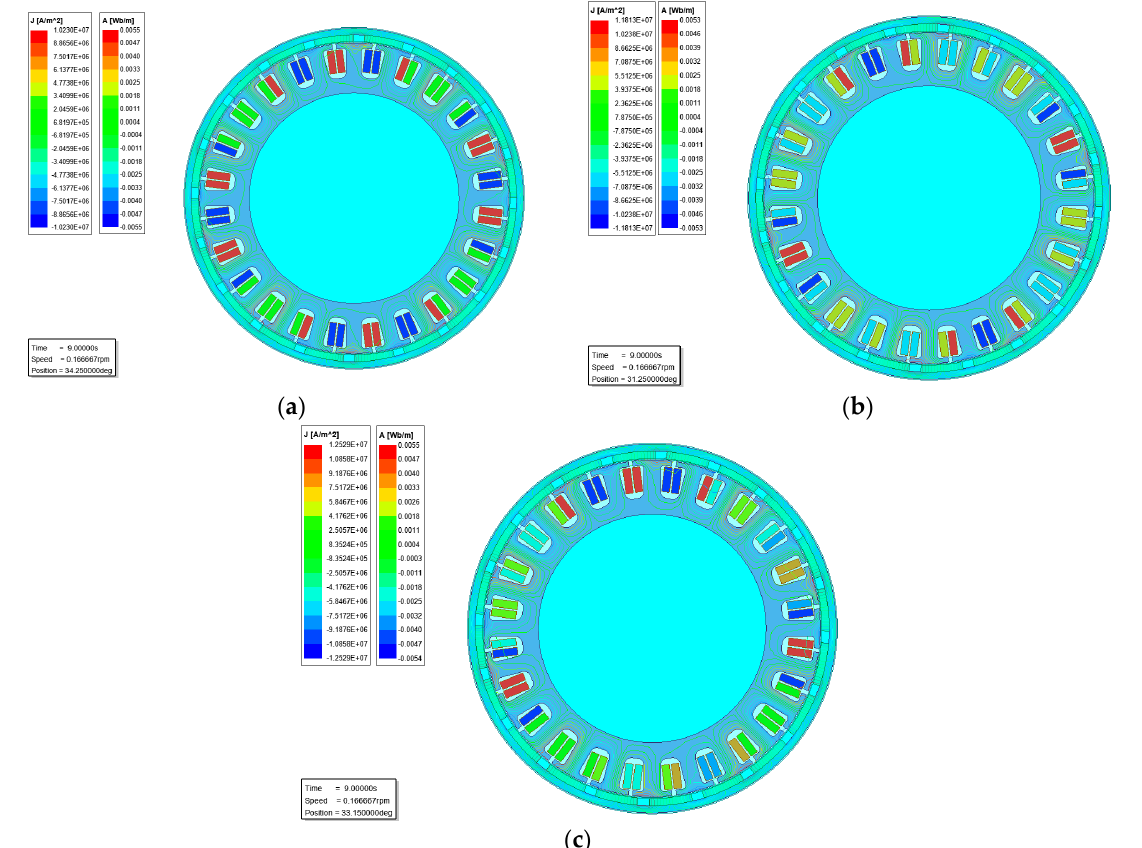
Figure 3. Distribution of current densities and magnetic flux: ( a ) star; ( b ) delta; ( c ) star–delta configurations.